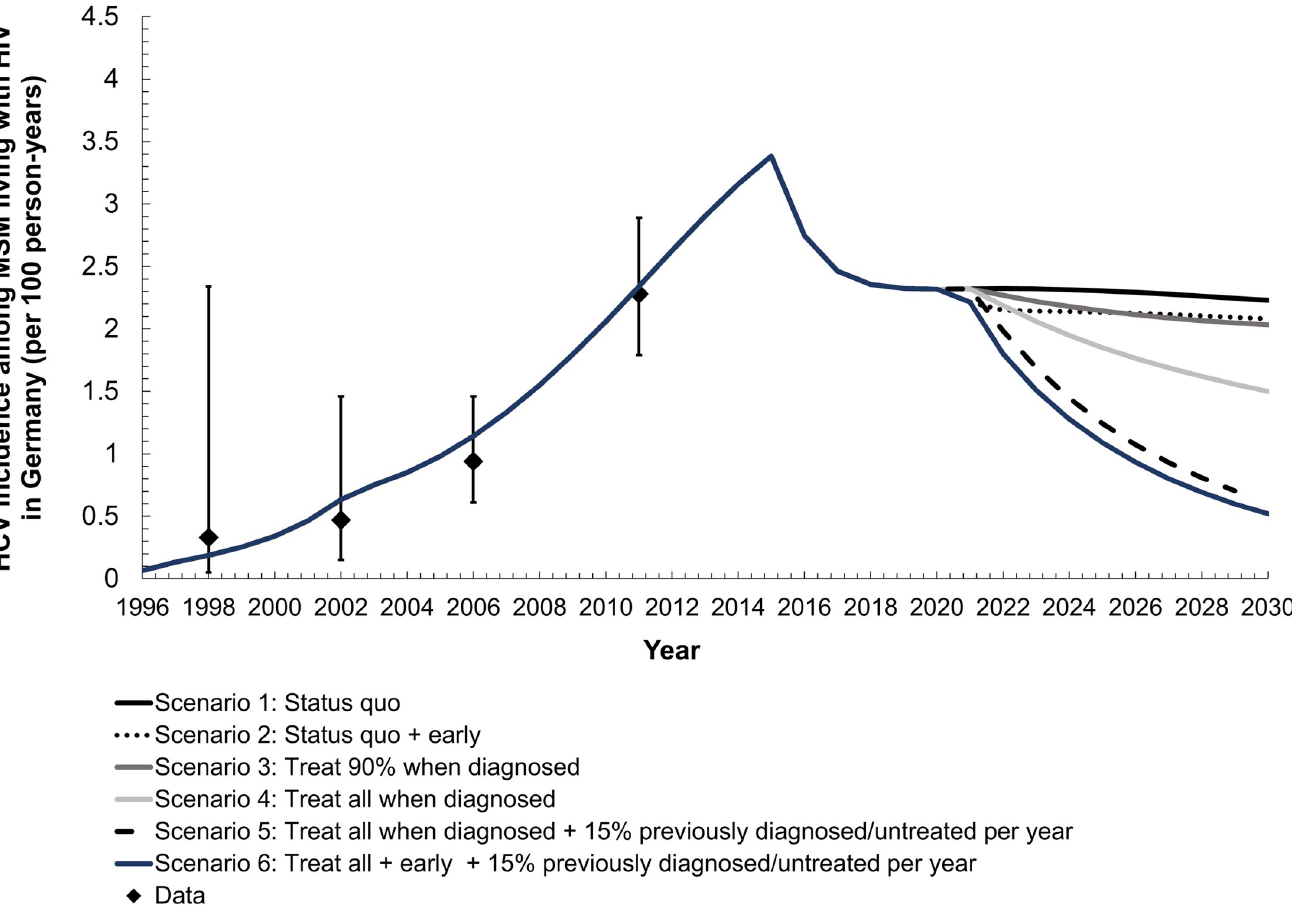
Fig 2. Primary hepatitis C virus (HCV) incidence among men who have sex with men living with diagnosed human immunodeficiency virus (HIV) in Germany. Diamonds represent mean epidemiological data estimate; whiskers, 95% confidence intervals; solid lines, the mean model trajectories. ‘Early’ refers to all newly diagnosed HCV infections treated within 3